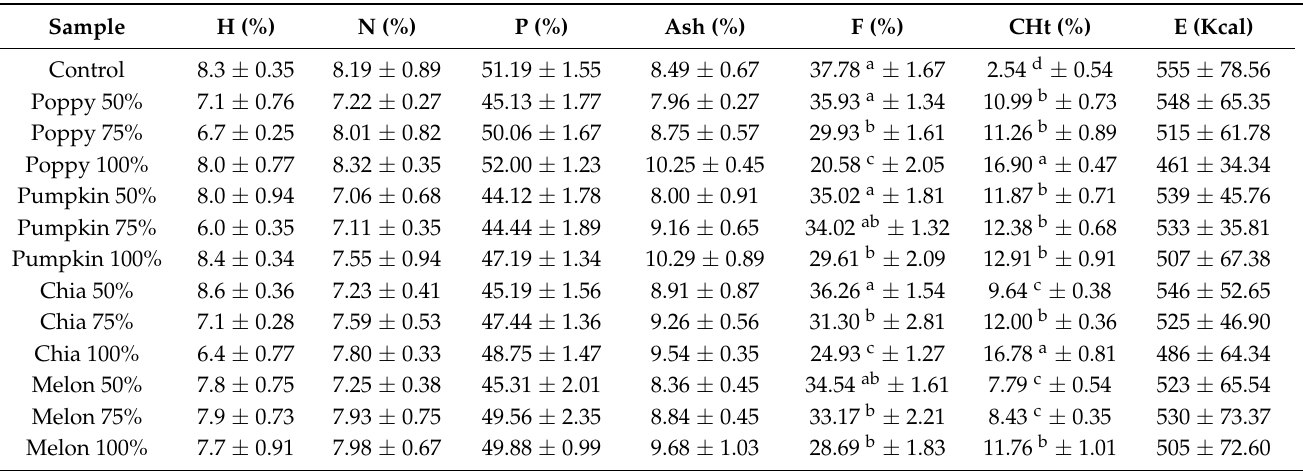
Table 3. Results of the nutritional evaluation of the fuet samples prepared with different emulsified seed oils.